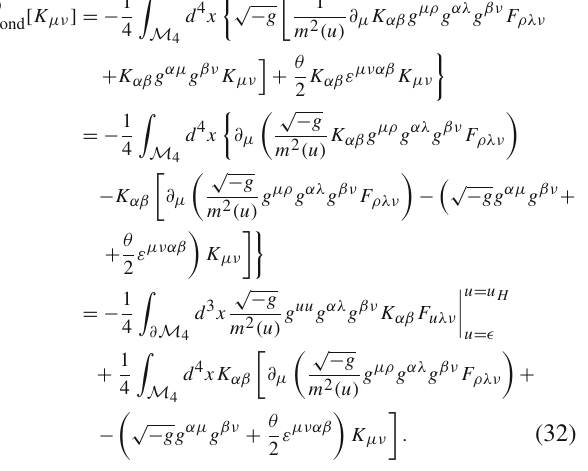
Fig. 7 Real and imaginary parts of the diagonal AC conductivity as functions the θ -angle and the dimensionless frequency variable, w = 3 ω/ 4 π T , for C (cid:12) = (cid:12) L / 2 = 2 (dimensionless combination involv-